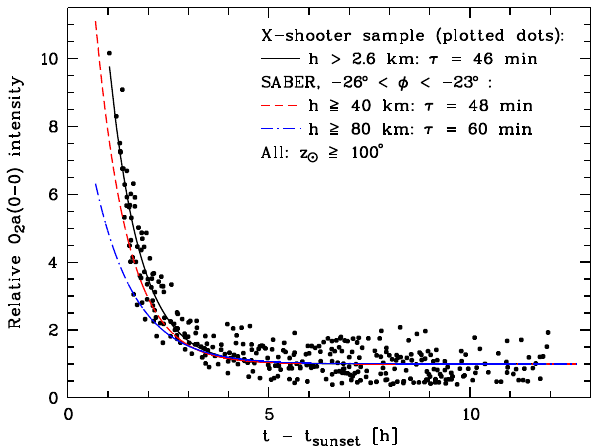
Figure 6. Derivation of O 2 a (0-0) T rot . The plot is similar to Fig. 4. Resulting from S R (circles) and O P (diamonds) line intensities, the mean populations of the odd rotational levels with N (cid:48) from 13 to 23 for the full X-shooter sample are shown. Filled symbols mark reliable data points that were used for the derivation of T rot (see Fig. 5), which is illustrated by the solid regression line.